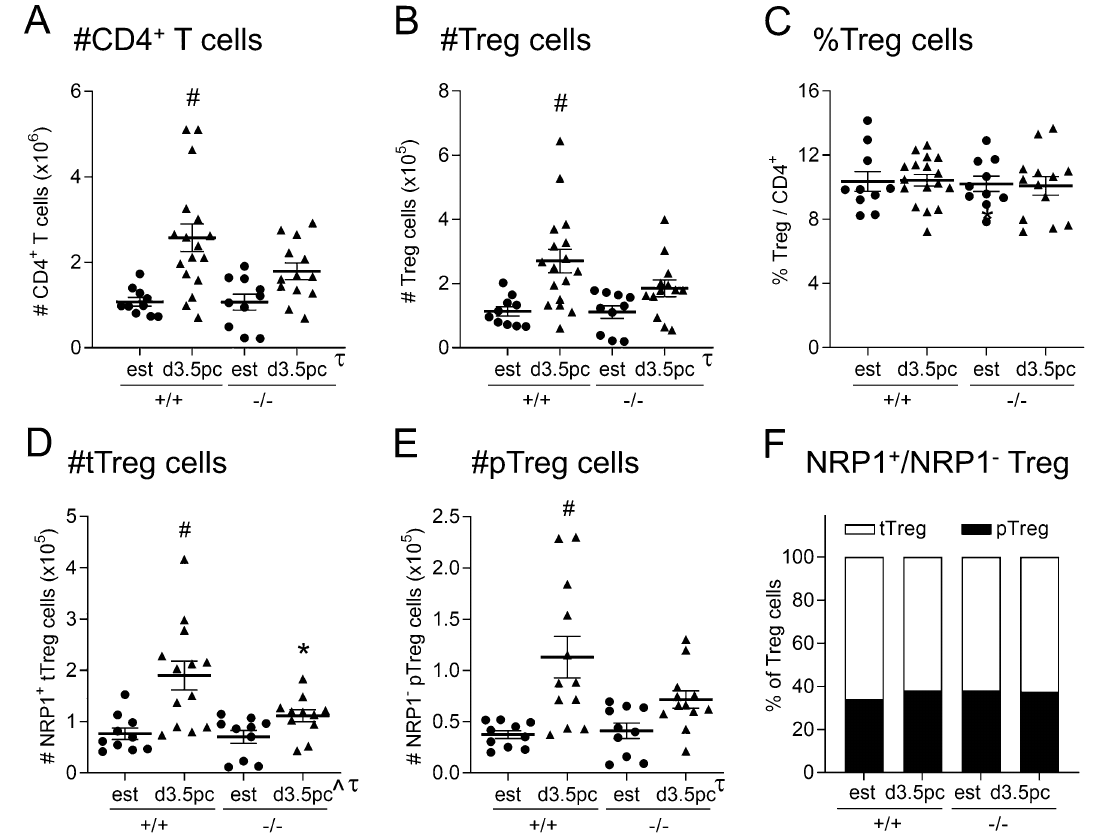
Figure 4. Effect of maternal TLR4 deficiency on CD4 + , Treg, tTreg, and pTreg cells in the uterine dLN after mating. Cells harvested from the dLN of Tlr4 + / + (+/+) and Tlr4 −/− (−/−) mice at estrus, or on d 3.5 pc after mating with B6 males, were analyzed by flow cytometry to assess phenotype and numbers of CD4 + T cells, Treg cells (defined as CD4 + CD25 + FOXP3 + ), tTreg (NRP1 + Treg), and pTreg (NRP1 − Treg) cells. The total number of CD4 + T cells ( A ) and Treg cells ( B ) and the percentage of Treg cells within the CD4 + population were assessed ( C ). The absolute number of NRP1 + tTreg ( D ) and NRP1 − pTreg ( E ) cells was measured, and the proportion of NRP1 + tTreg (white) and NRP1 − pTreg (black) cells within the Treg cell population was calculated ( F ). Symbols depict individual mice (n = 10–17/group) and data are shown as mean ± SEM. Differences between groups were assessed by one-way ANOVA with Sidak t test (* p < 0.05 between genotype of the same mating status; # p < 0.05 between estrus and mating within a genotype). The overall effect of genotype and mating was assessed by two-way ANOVA ( τ p < 0.05 difference attributable to mating; ^ p < 0.05 difference attributable to genotype). Gating strategy is shown in Supplemental Fig. S2, and FOXP3 mean fluorescence intensity (MFI) is shown in Supplemental Fig.